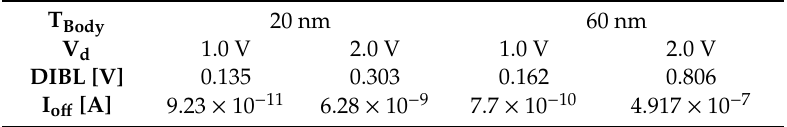
Table 3. Drain induced barrier lowering (DIBL) and o ff region current according to di ff erent drain voltage conditions and body thickness of poly-Si 1T-DRAM